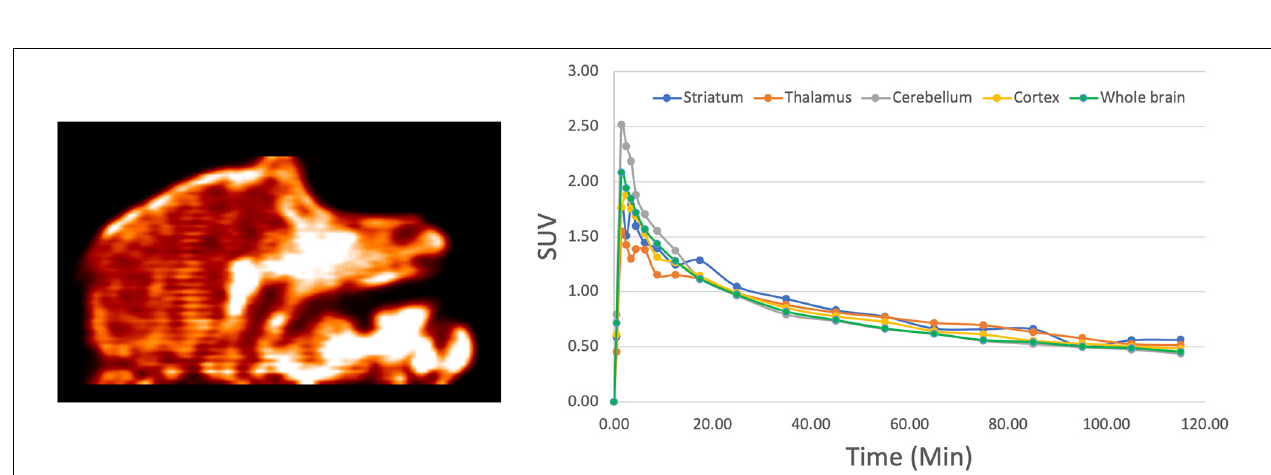
FIGURE 5 | Representative NHP PET imaging with [ 18 F]1 : summed sagittal image (0–120 min post i.v. injection of the radioligand) and average regional time-radioactivity curves ( n = 2).